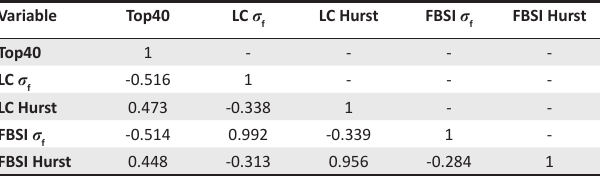
TABLE 1: Correlation matrix of weekly log returns on Top40 index and associated implied volatility parameters, September 2005 to November 2015.